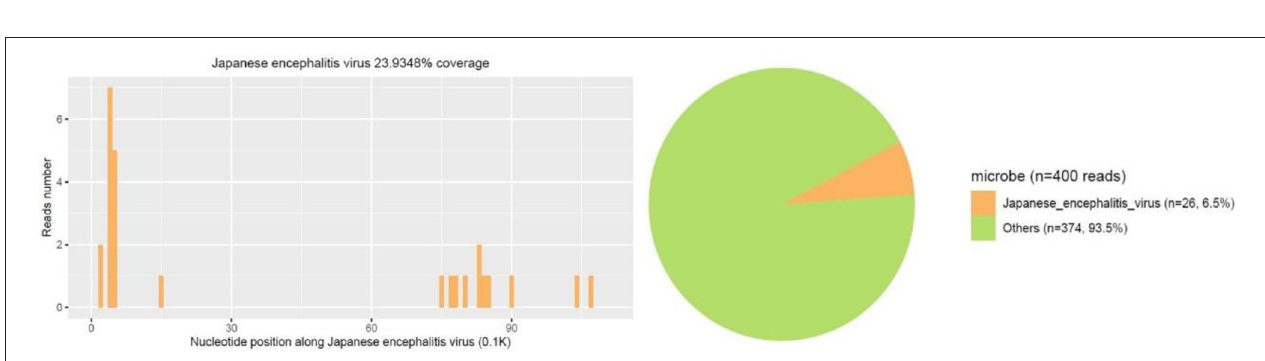
FIGURE 1 | (A) MRI brain axial T1: slightly hypointensity in the symmetric thalamus, head of caudate nucleus, and right lenticular nucleus (B) MRI brain axial T2: hyperintensity in the symmetric hippocampus, thalamus, head of caudate nucleus, and right lenticular nucleus. (C,D) MRI brain axial diffusion-weighted imaging: isointensity bilateral punctate hyperintensity in the symmetric thalamus, and showed hypointensity in ADC. (E) MRI brain axial T2 fluid-attenuated inversion recovery: slightly hyperintensity in the symmetric thalamus, head of caudate nucleus, no mass effect. (F) MRI brain axial T2 fluid-attenuated inversion recovery: The lesions had disappeared completely after 2